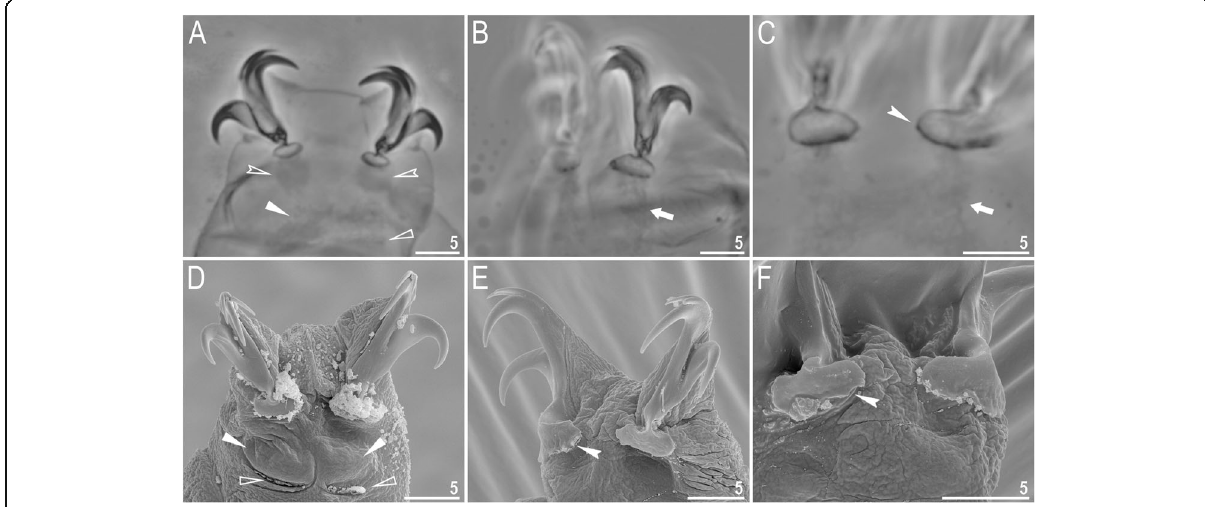
Fig. 6 Macrobiotus pallarii Maucci, 1954 from the topotypic population (IT.337) – claw morphology: a – b – claws I and IV seen with LCM; c – magnification on lunulae IV seen with LCM; d – e – claws II and IV seen in SEM; f – magnification on lunulae IV seen with SEM. Empty indented arrowheads indicate dark circular areas under lunulae on the first three pairs of legs, filled flat arrowheads indicate cuticular bars above muscle attachments, empty flat arrowheads indicate double muscle attachments under claws, filled indented arrowheads indicate faintly visible indentations on lunulae IV, arrows indicate horseshoe structures connecting the anterior and posterior claws. Scale bars in μ